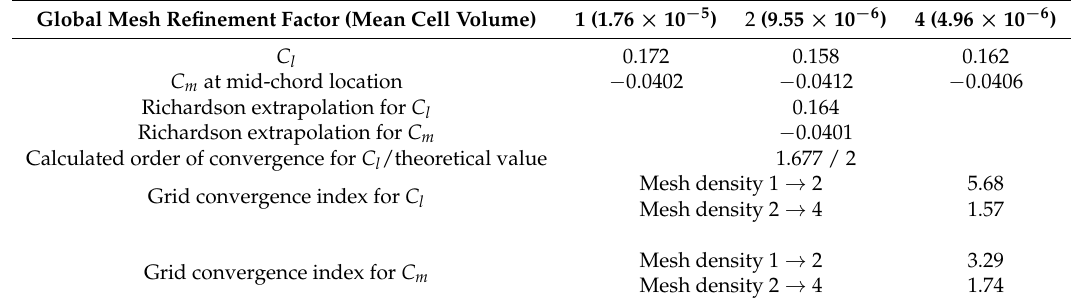
Table A2. Grid convergence study for the undeformed plate wing at an incidence angle of 2 ◦ degrees.